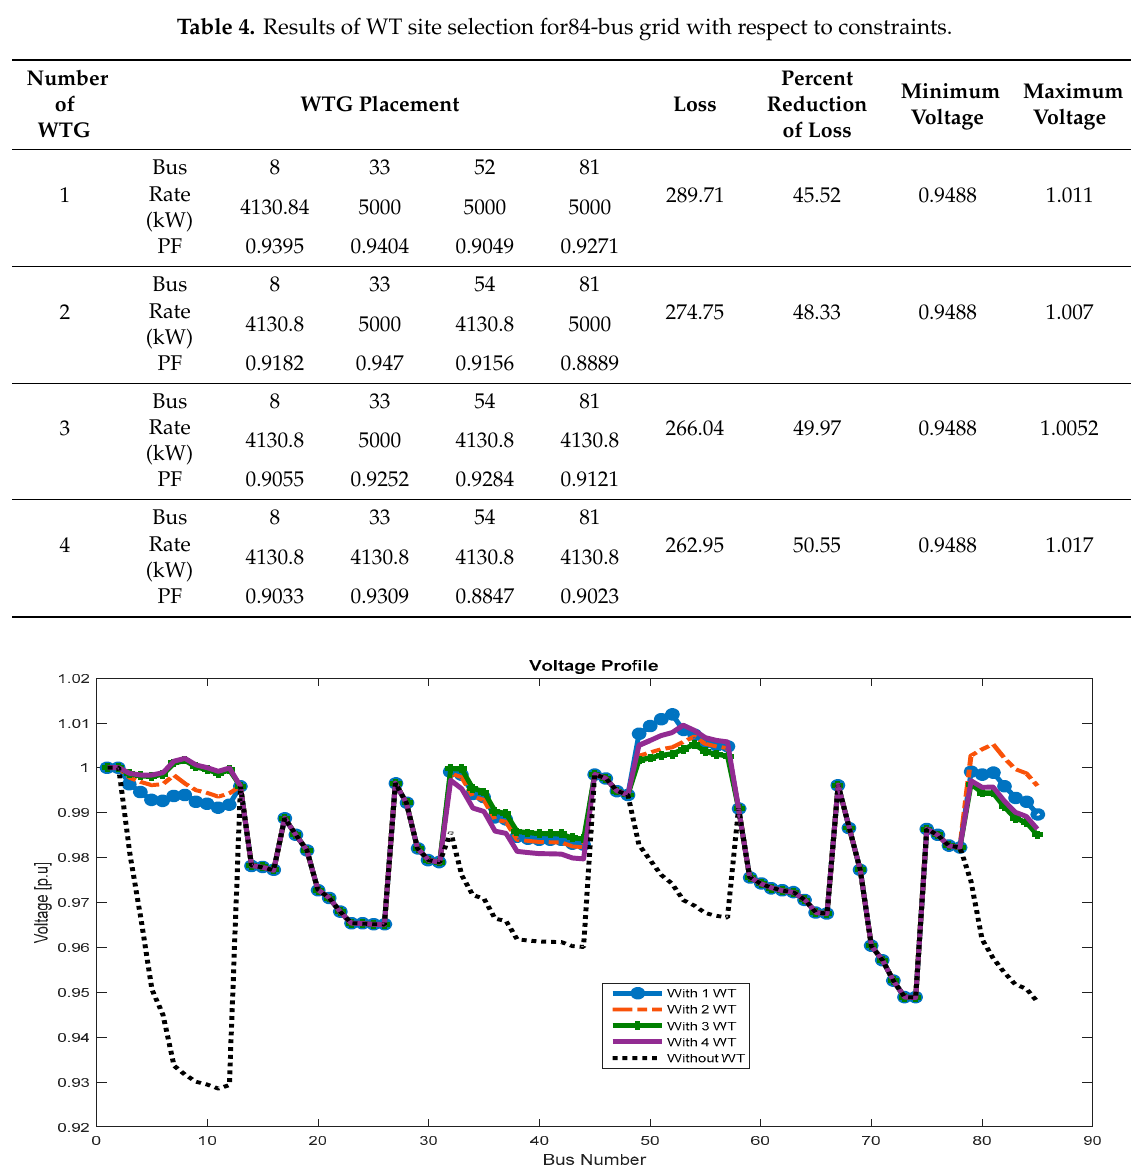
Table 4. Results of WT site selection for84-bus grid with respect to constraints.